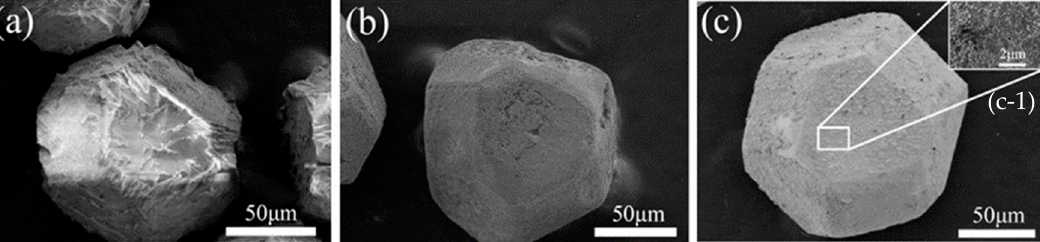
Figure 6. XRD patterns for the Cr–B–C-coated diamond particles after annealing at 1151 °C.